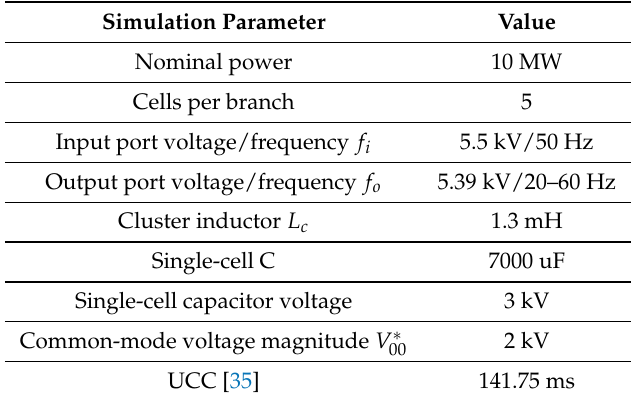
Table 1. Simulation